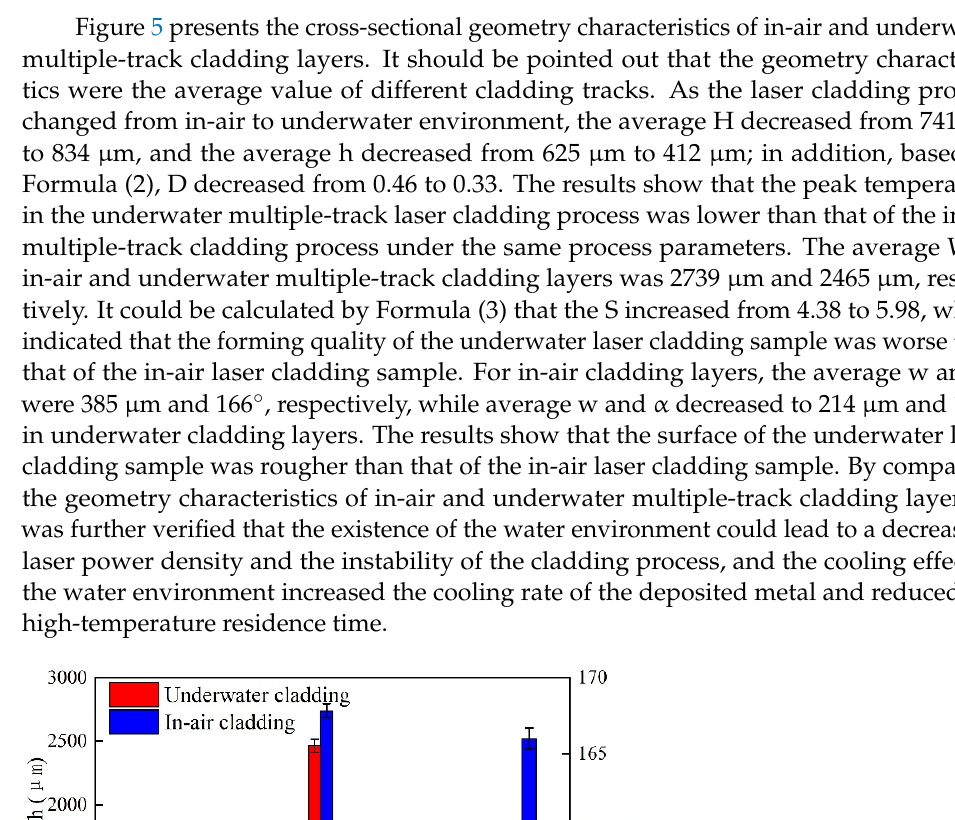
Figure 4. The cross-sectional images: ( a ) the underwater cladding layer; ( b ) the in-air cladding layer.